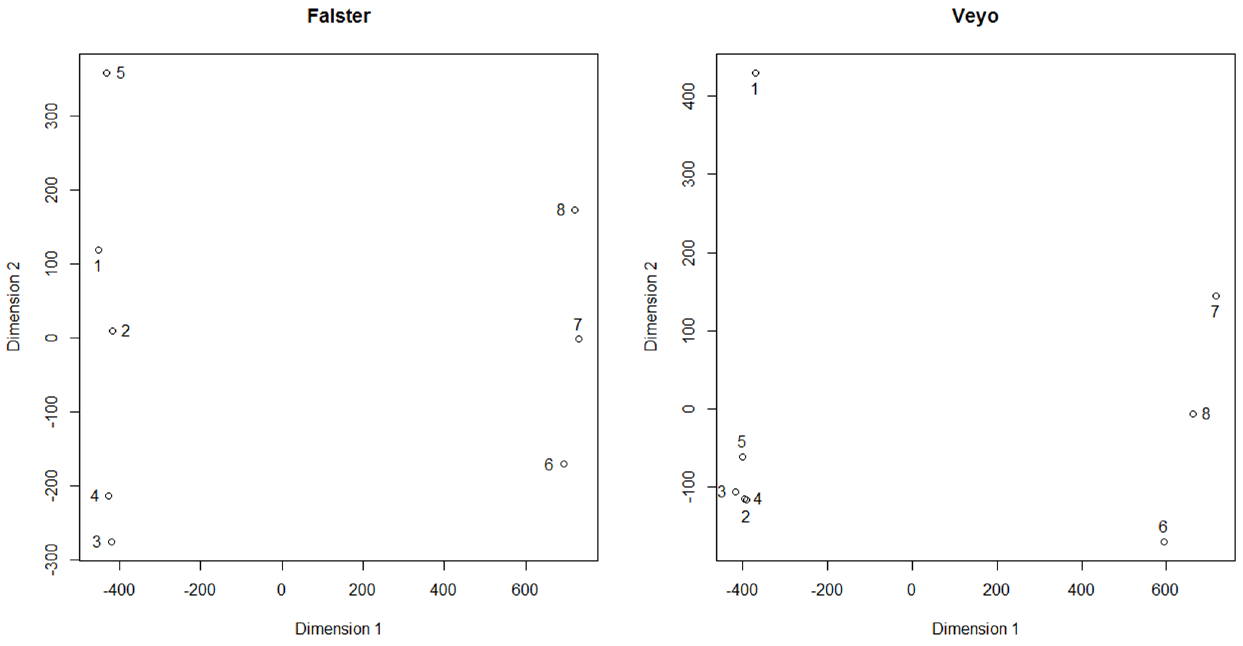
Figure 1. Multidimensional scaling plots of the Falster and Veyo transcriptome assemblies. The first dimension illustrates grouping based on sample type. The second dimension illustrates grouping based on the sample collection time points (stage of induction). The numbers illustrate the samples as follows: 1= leaf samples collected before the start of vernalization; 2= leaf samples collected after two days of vernalization; 3= leaf samples collected after four weeks of vernalization; 4= leaf samples collected after nine weeks of vernalization; 5= leaf samples collected after seven long days; 6= enriched meristem samples collected after nine weeks of vernalization; 7= enriched meristem samples collected after one long day; 8= enriched meristem samples collected after seven long